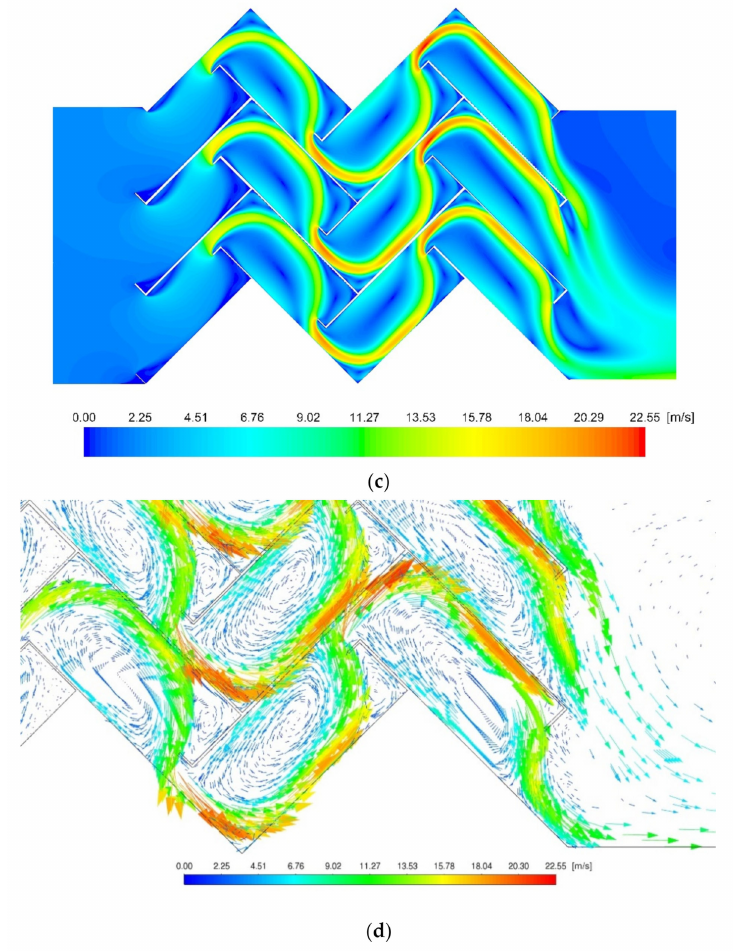
Figure 10. Velocity fields ( a , c ) (m s − 1 ) and vectors ( b , d ) and vectors (m s − 1 ) of investigated geometry variants with different drainage channel lengths: ( a , b ) B_10_0; ( c , d ) B_25_0; with inlet velocity 2 m s − 1 simulated using a transition SST model.